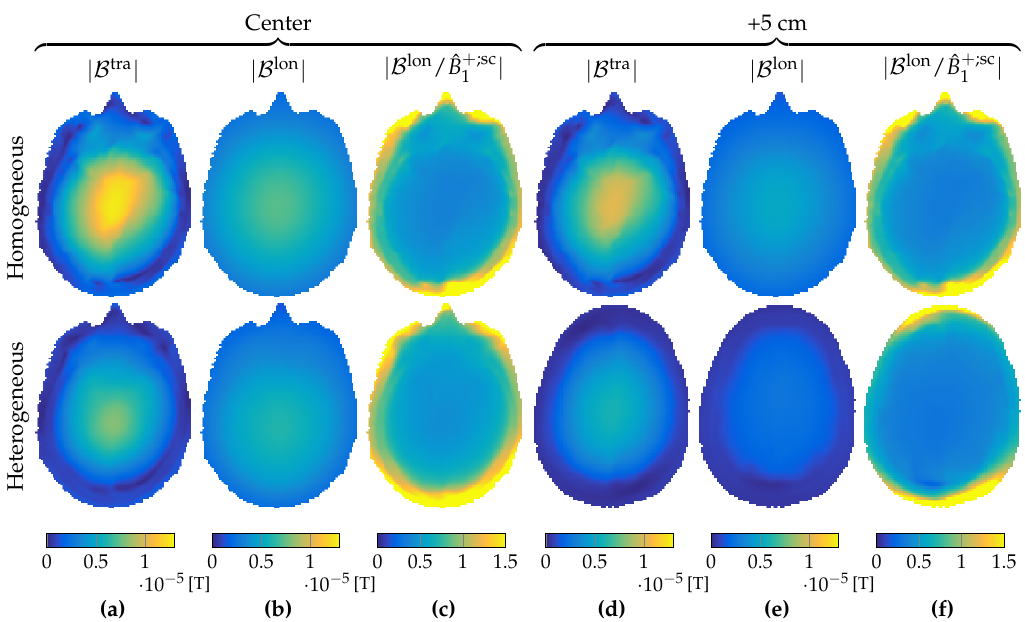
terms. ( a ) Transverse variation and ( b ) longitudinal variation term 1 Figure 5. Magnitude of scattered ˆ B + 1 lon with regard to ˆ B + ;sc of the scattered ˆ B + , and ( c ) contributions of at the center slice. ( d – f ) Same, 1 1 B respectively, at a slice 5 cm higher in the head domain. Top row is in the case of a longitudinally uniform object, the bottom row for the head model with longitudinal variations. ( b ) and ( e ) were neglected in the 2D